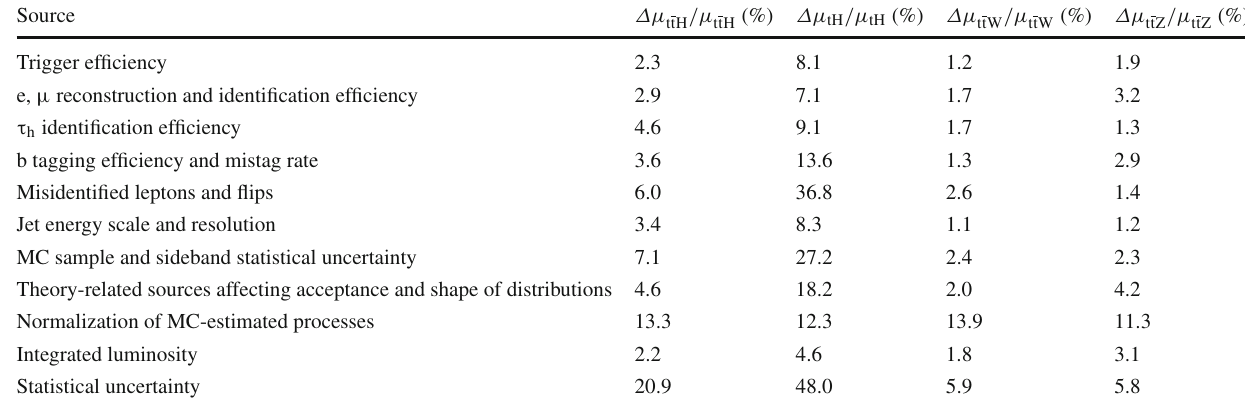
Table 7 Summary of the sources of systematic and statistical uncer- tainties and their impact on the measurement of the ttH and tH signal rates, and the measured value of the unconstrained nuisance parame- ters. The quantity Δμ x /μ x corresponds to the change in uncertainty when fixing the nuisance parameters associated with that uncertainty